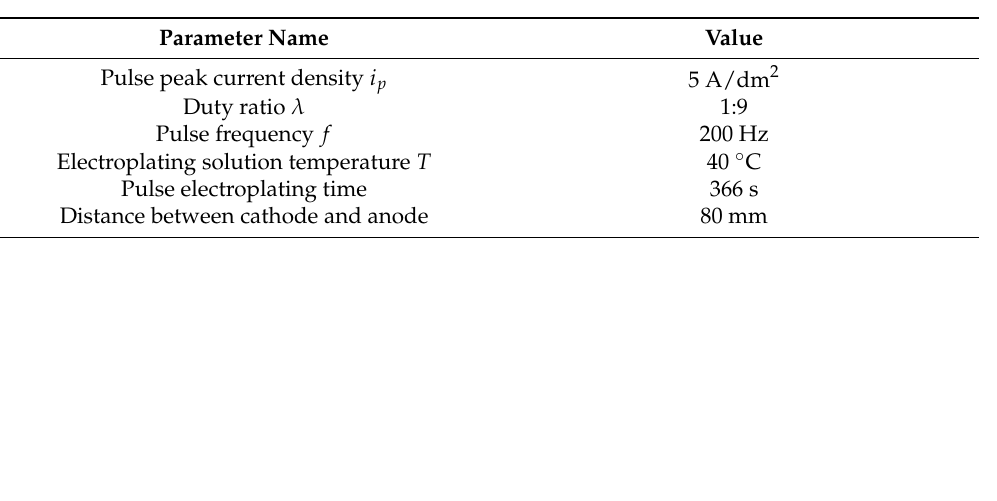
Table 1. Optimized pulse electroplating parameters.